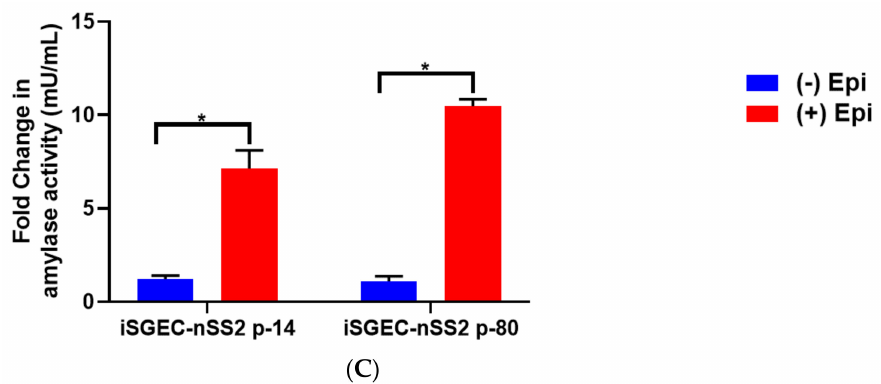
Figure6. ProteinexpressionofacinarandepithelialcellmarkersbyWesternblotiniSGEC-nSS2. Legend. ( A ) Protein expression of acinar (AQP5) ( left ) and epithelial (ZO-1) ( middle ) markers in whole-cell lysate of monolayer cultured iSGEC-nSS2. ( left ) Expression of AQP5 in iSGEC-nSS2 whole-cell lysate compared to HMC-3A, which was used as a ( + ) control for AQP5 in Western blots. ( right ) After stimulation with 10 µ M epinephrine for 45 min (( + ) Epi) cell culture supernatant was replaced, and cells were grown for 72 h before media were collected and concentrated. Cells without stimulation by media supplementation with 10 µ M epinephrine (( − ) Epi) served as the control. Secreted α -amylase was detected in both stimulated (( + ) Epi) and unstimulated (( − ) Epi) cultures. 10 µ M epinephrine stimulated (( + ) Epi) iSGEC-nSS2 cultures exhibited higher levels of α -amylase in cell culture supernatant than unstimulated cultures after 72 h. Western blots were normalized to vinculin expression in whole-cell lysate of their respective sample. ( B , C ) Media were harvested after stimulation with 10 µ M epinephrine for 45 min and amylase activity measured by colorimetric assay. ( B ) Supernatant of monolayer cultured iSGECs treated with 10 µ M (( + ) Epi) had significantly higher α -amylase activity compared to untreated cells (( − ) Epi). (C) Comparison of early (p-14) and late (p-80) passaged iSGEC-nSS2 secretion of α -amylase into media when cultured on matrigel. Results are listed as fold-change over the untreated control. Significance of di ff erences between means was determined by Student’s t -test and p -values corrected using the Holm–Šid á k multiple comparisons test (alpha = 0.05). Error bars represent